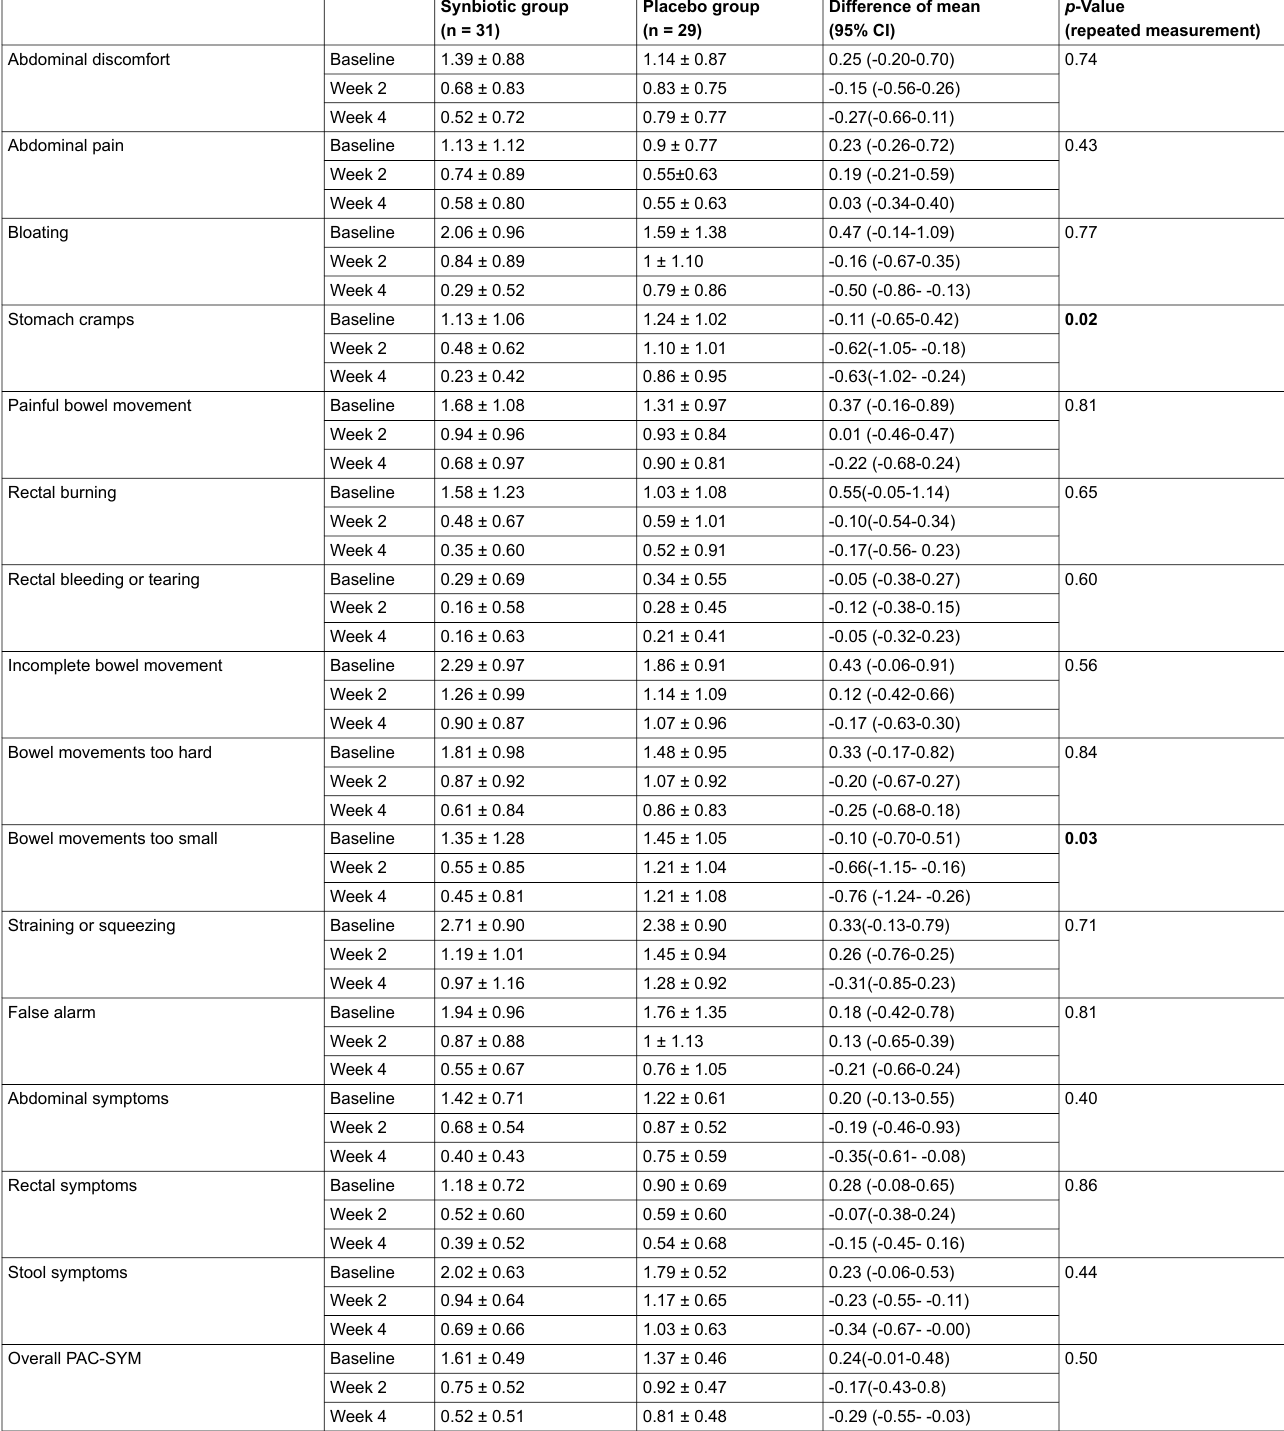
Table 4: Comparison of “Patient assessment of constipation symptoms questionnaire” (PAC-SYM) values at baseline, weeks 2 and 4 in the synbiotic and placebo groups. Data were expressed as mean ± standard